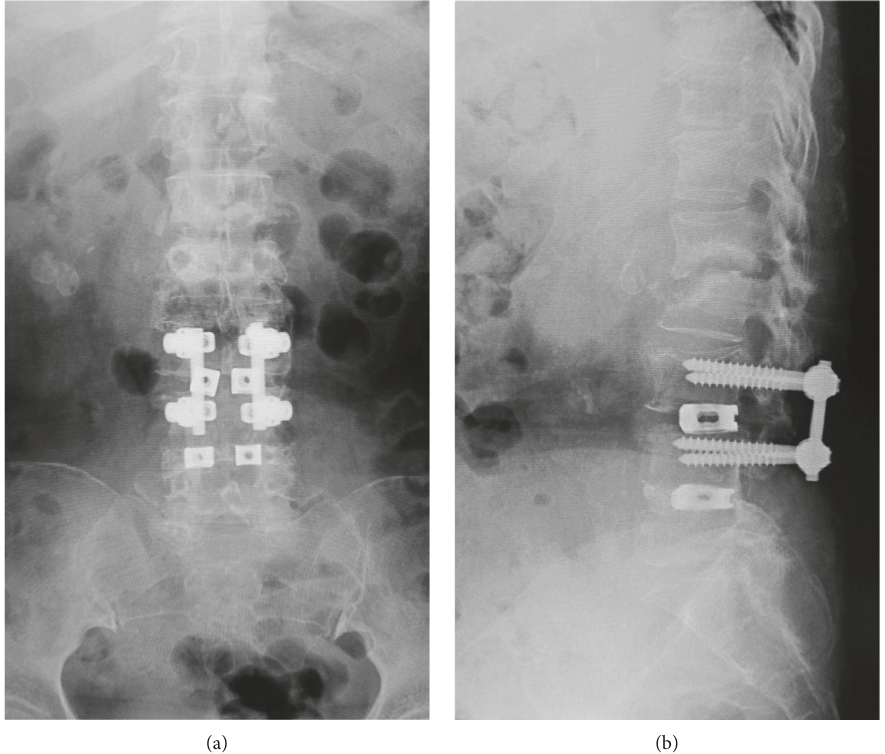
Figure 5: Case 2: plain anteroposterior (a) and lateral (b) radiographs showed progressive vertebral destruction at the L1-2 level after partial removal of the implant.